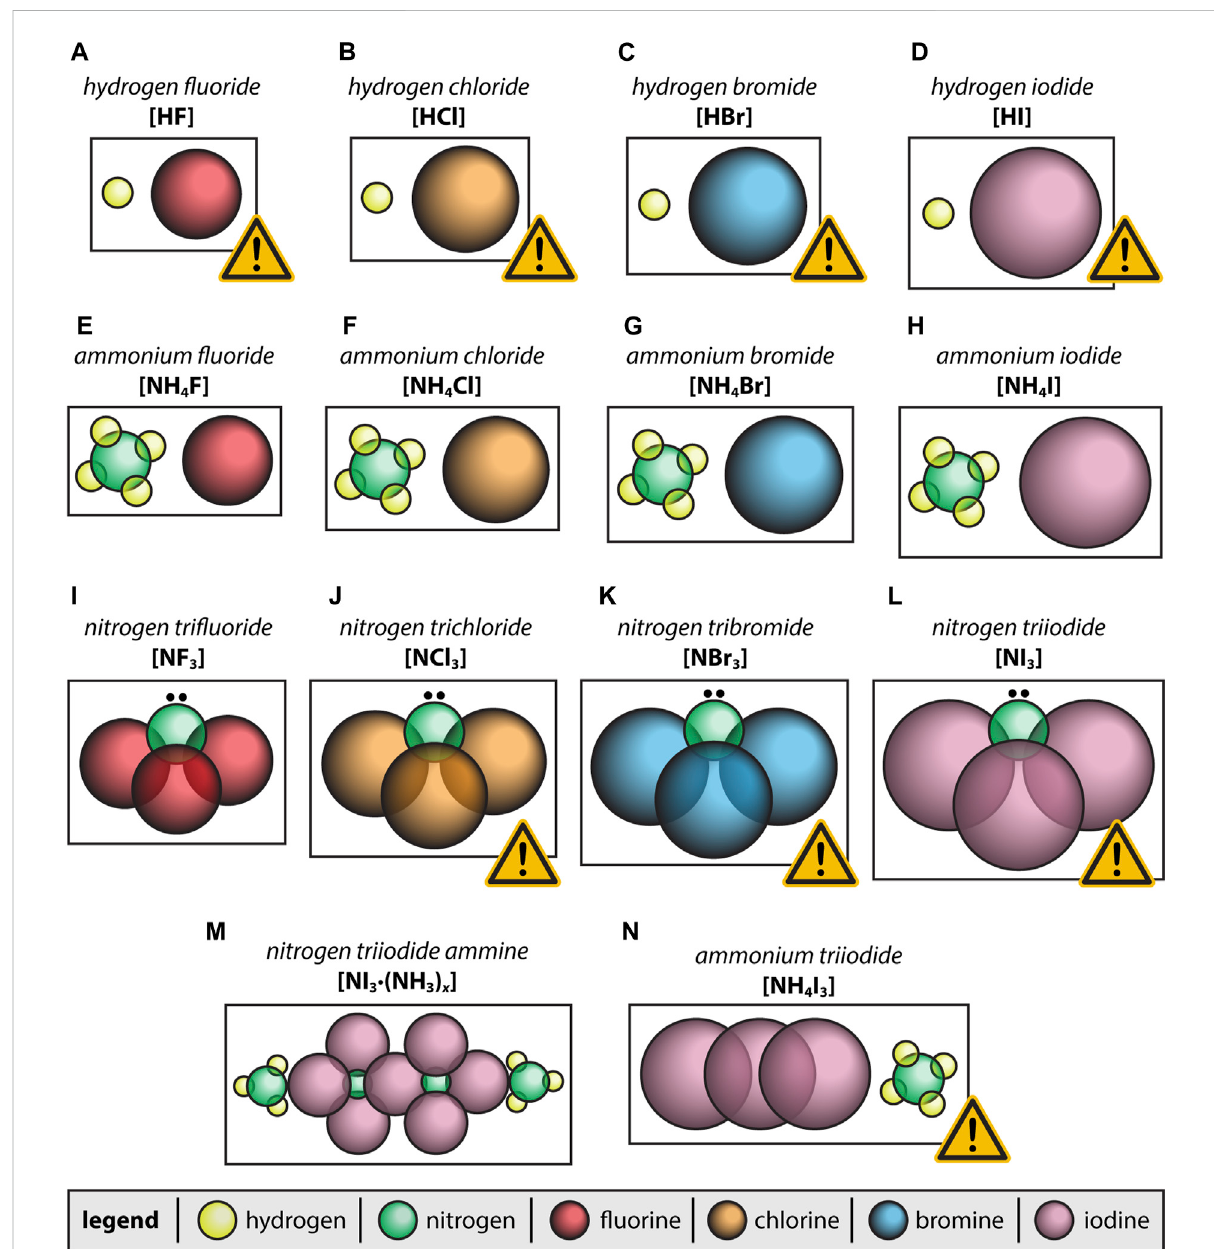
FIGURE 2 Potentialhalogen-basedbyproductsgeneratedduringdehalogenationprocessesincluding (A – D) hydrogenhalides; (E – H) ammoniumhalides; (I – L) nitrogen trihalides; (M) NI 3 · (NH 3 ) x ammine adduct where x = 1, 2, 3, 5, or 12; and (N) NH 4 I 3 . The yellow triangles (!) for some species indicate additional hazards that are described in the text in more